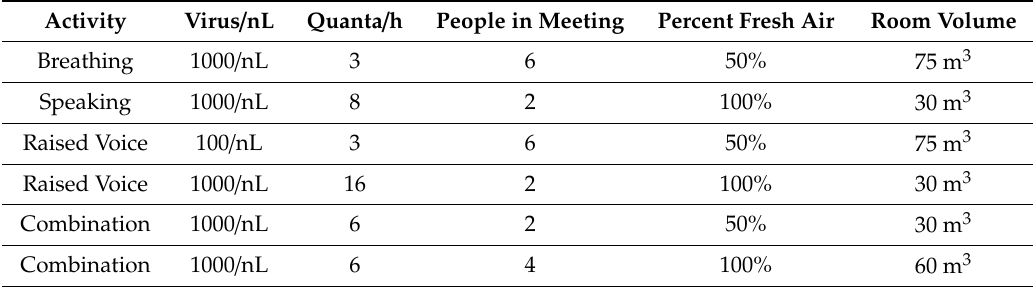
Table 6. Thresholds of 5% infection probability for di ff erent meeting